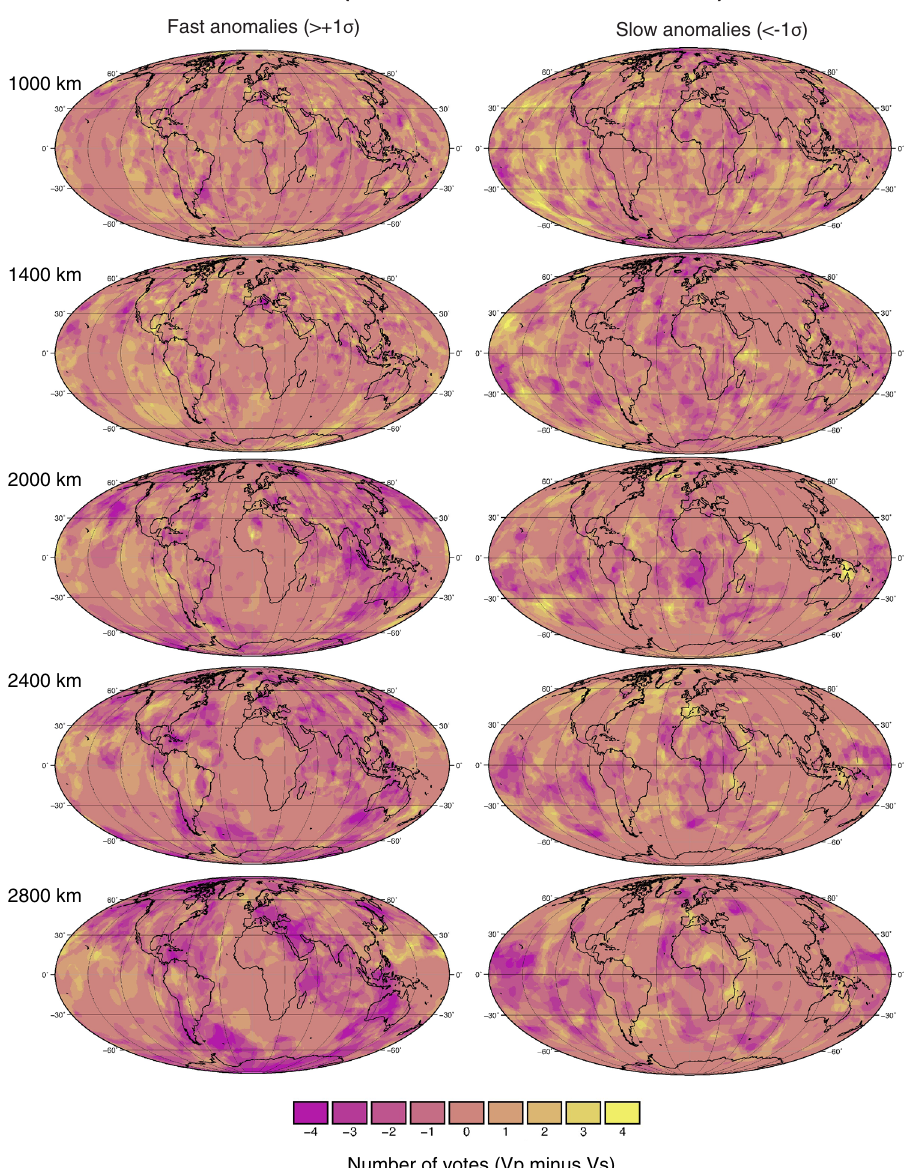
Fig. 7 Difference maps between P-wave and S-wave models. Difference maps for the fast (left panels) and slow (right panels) vote maps constructed by subtracting the S-wave model votes (constructed with 4 models) from P-wave model votes (constructed with 4 models). Yellow areas indicate high votes (i.e. the identi fi cation of robust features) in P-wave models but not S-wave models, darker purple areas indicate high votes for S-wave models relative to P-wave models, and central colours indicate regions of mutual